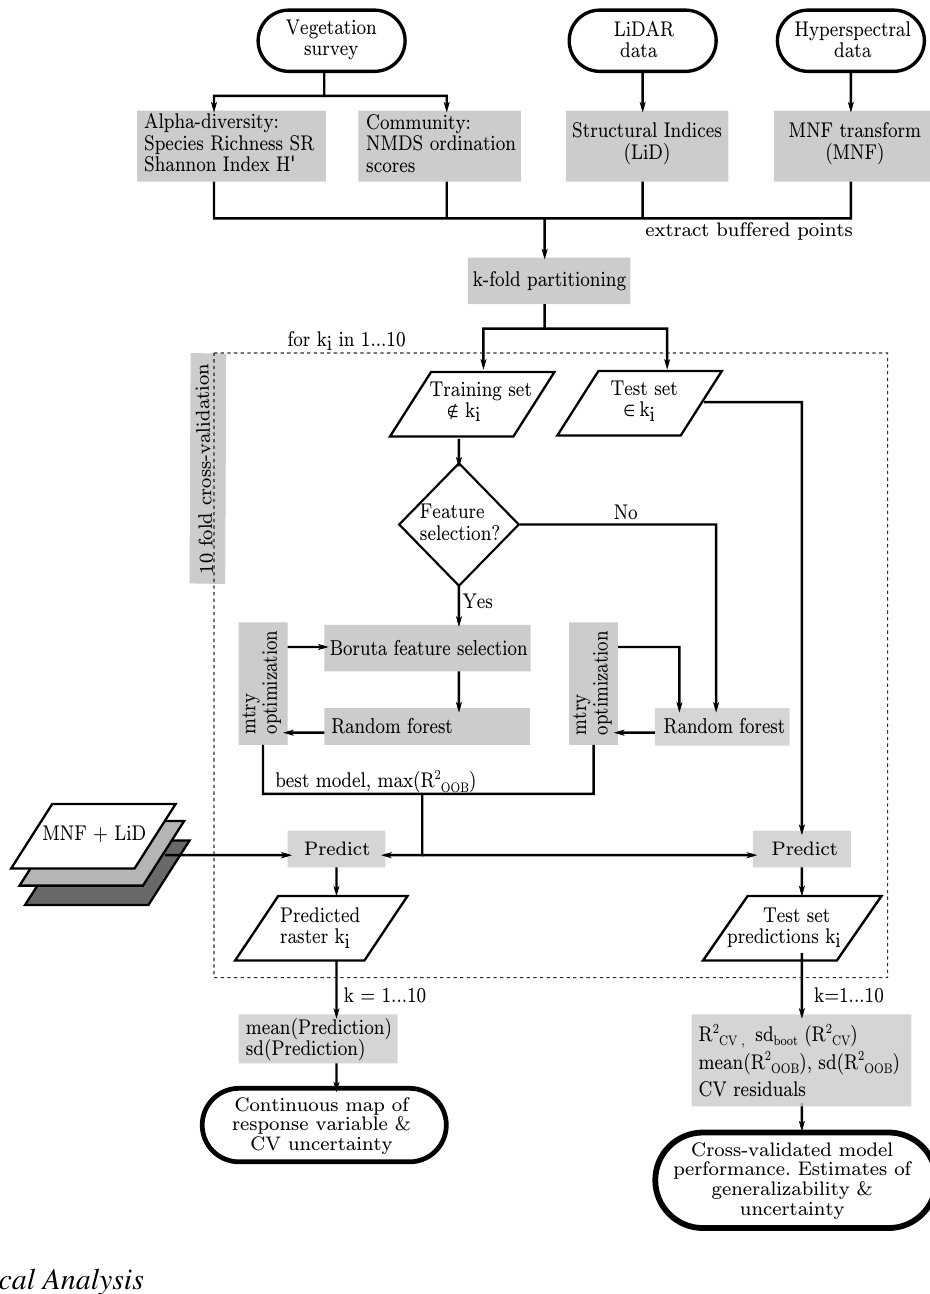
Figure 2. Processing framework. Predictor variables were derived from LiDAR (LiD) and hyperspectral (MNF) data. Biodiversity indicators ( SR , H (cid:48) ) and non-metric multidimensional scaling (NMDS) ordination scores of two NMDS axes were modelled as response variables (NMDS ,NMDS ). The procedure was repeated for herb, shrub and tree layer and their total, 1 2 using LiD, MNF and MNF+LiD predictors both with and without feature selection.